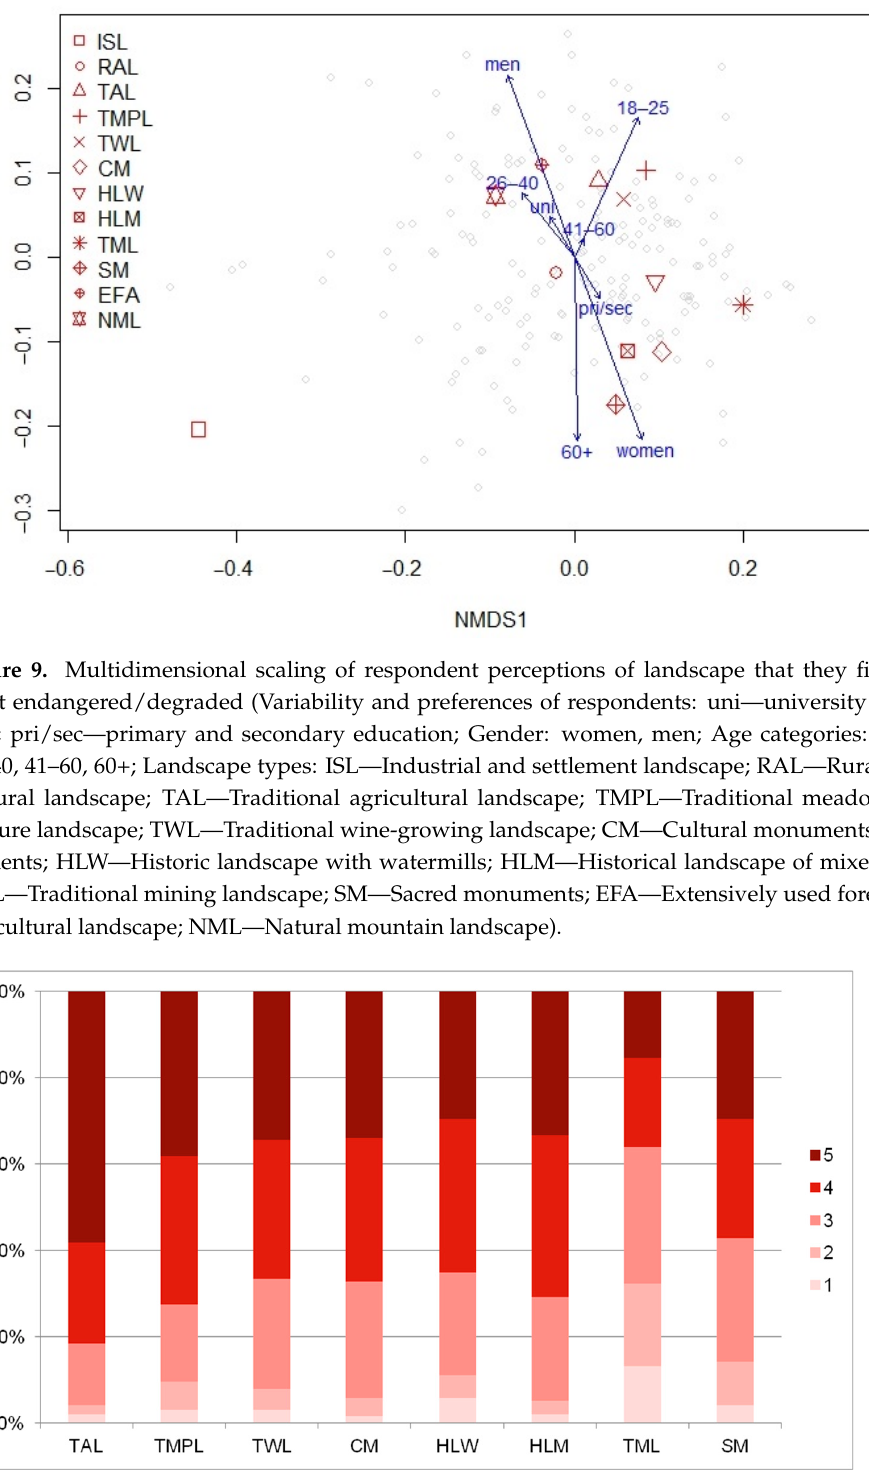
5—Under the greatest threat, 1—Under the least threat; landscape subtypes: ISL—Industrial and